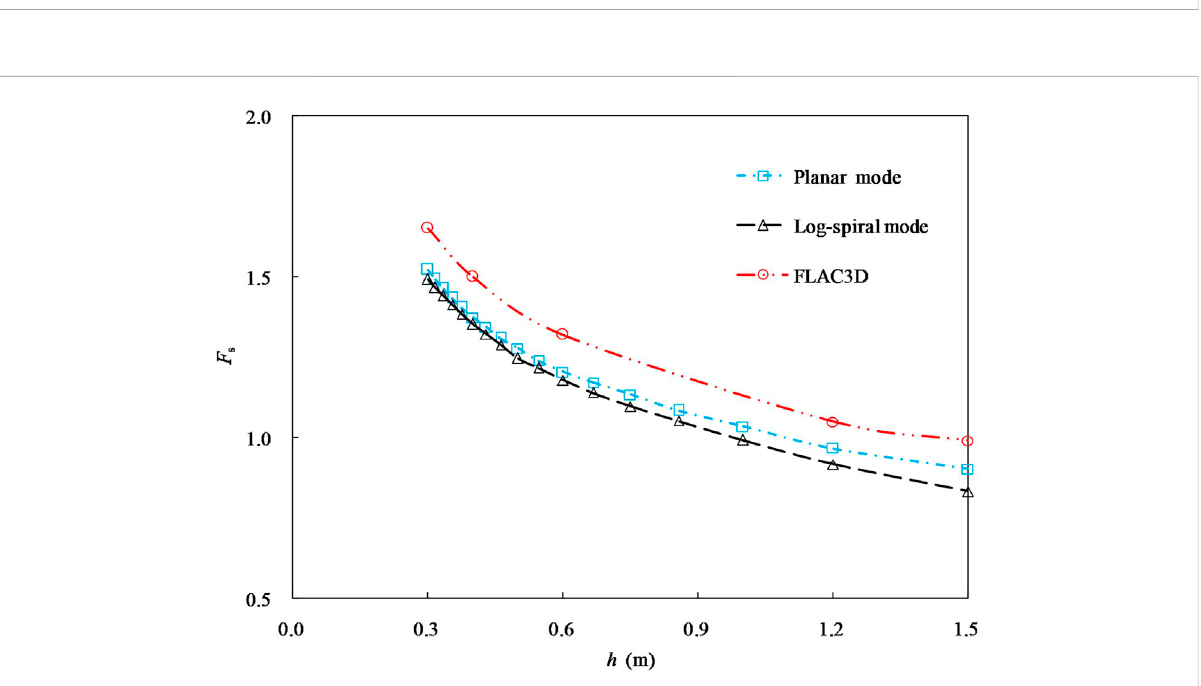
FIGURE 5 Calculation results of factor of safety using different